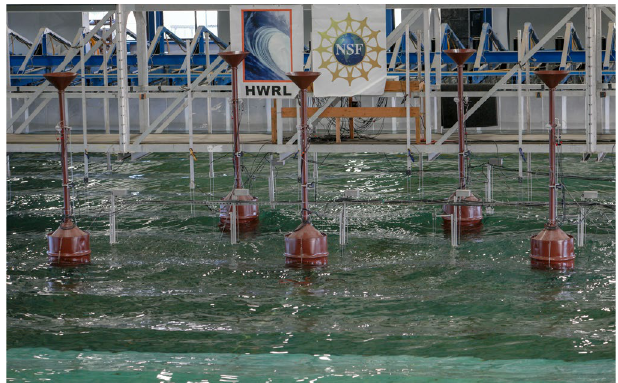
Fig. 1. Non-optimal array layout. Selected from literature search as a common array configuration.